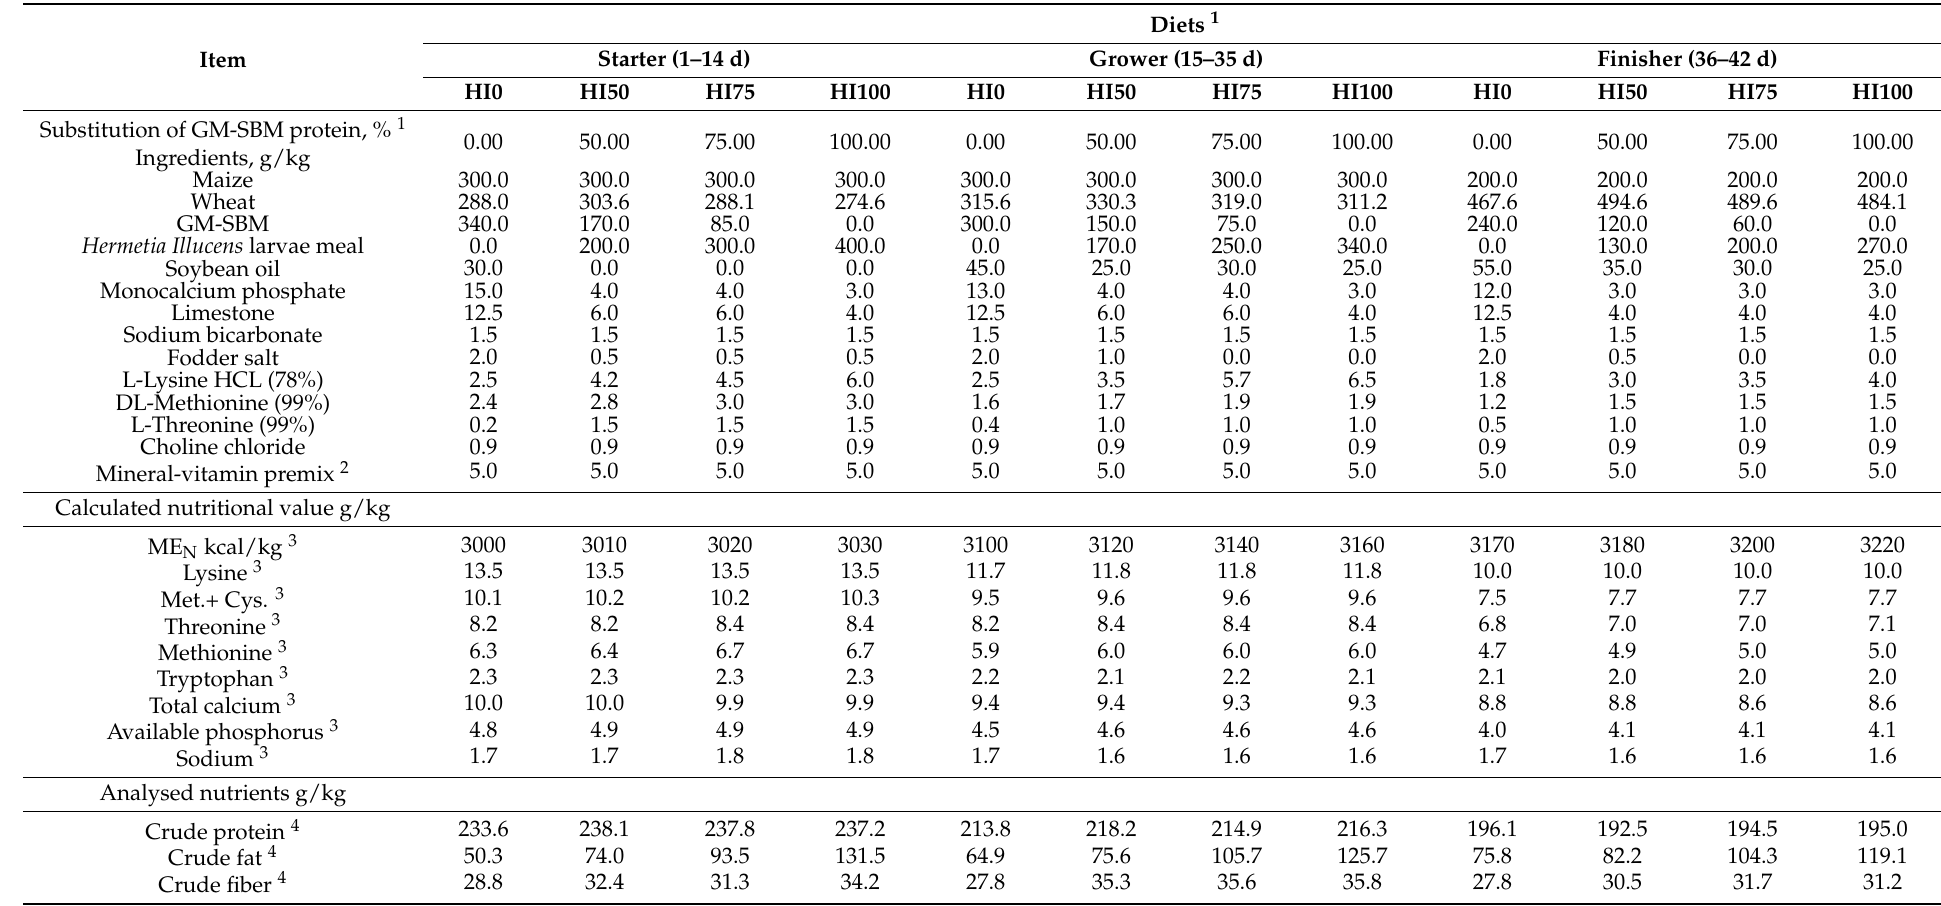
Table 2. Ingredients and nutritional value of broiler chicken diets with and without full-fat Hermetia illucens (HI) larvae